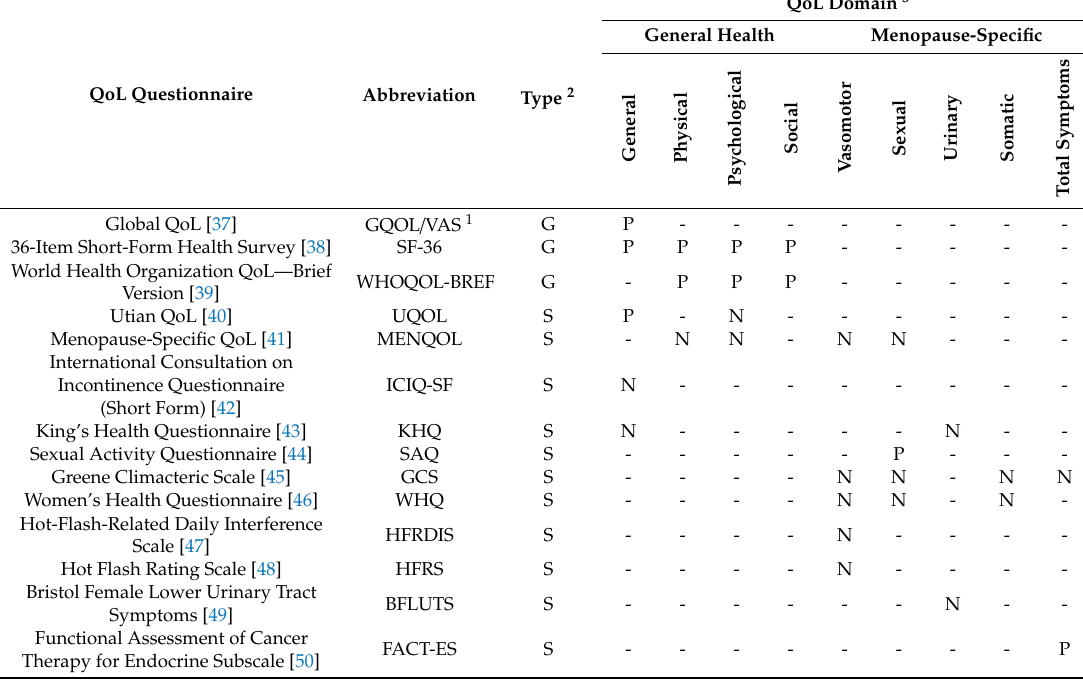
Table 1. Quality-of-life (QoL) questionnaires and